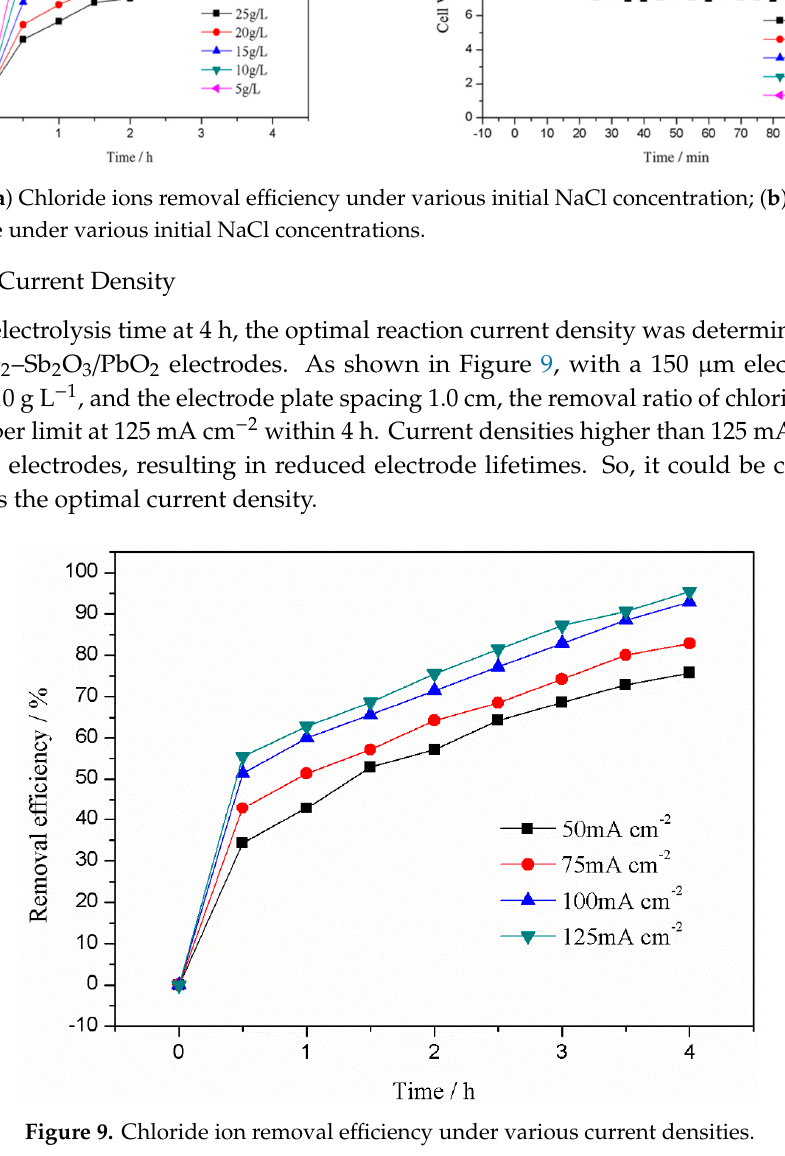
Figure 7. ( a ) Effect of pore size on chloride ion removal efficiency; ( b ) chloride ion removal efficiency as observed with 150 µm porous Ti/SnO 2 -Sb 2 O 3 and 150 µm porous Ti/SnO 2 -Sb 2 O 3 /PbO 2 electrodes.